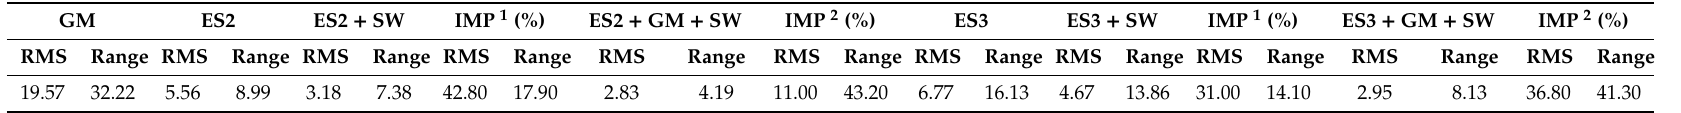
Table 5. Statistics of the average prediction precision (RMS), stability (Range), and improvement of the di ff erent models for 24 h